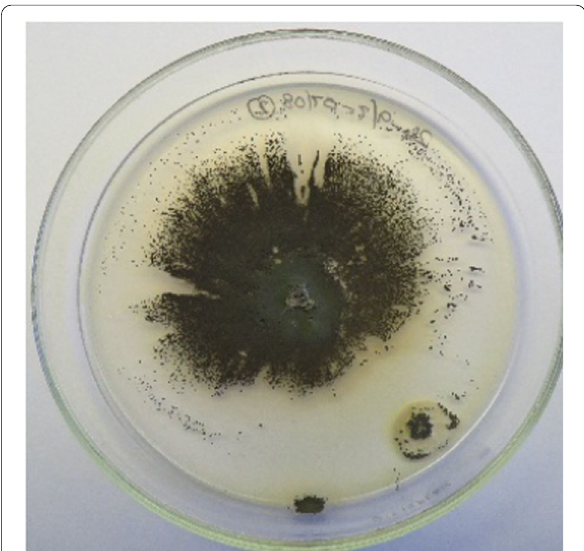
Fig. 7 Well-grown Metarhizium anisopliae on adult TMB